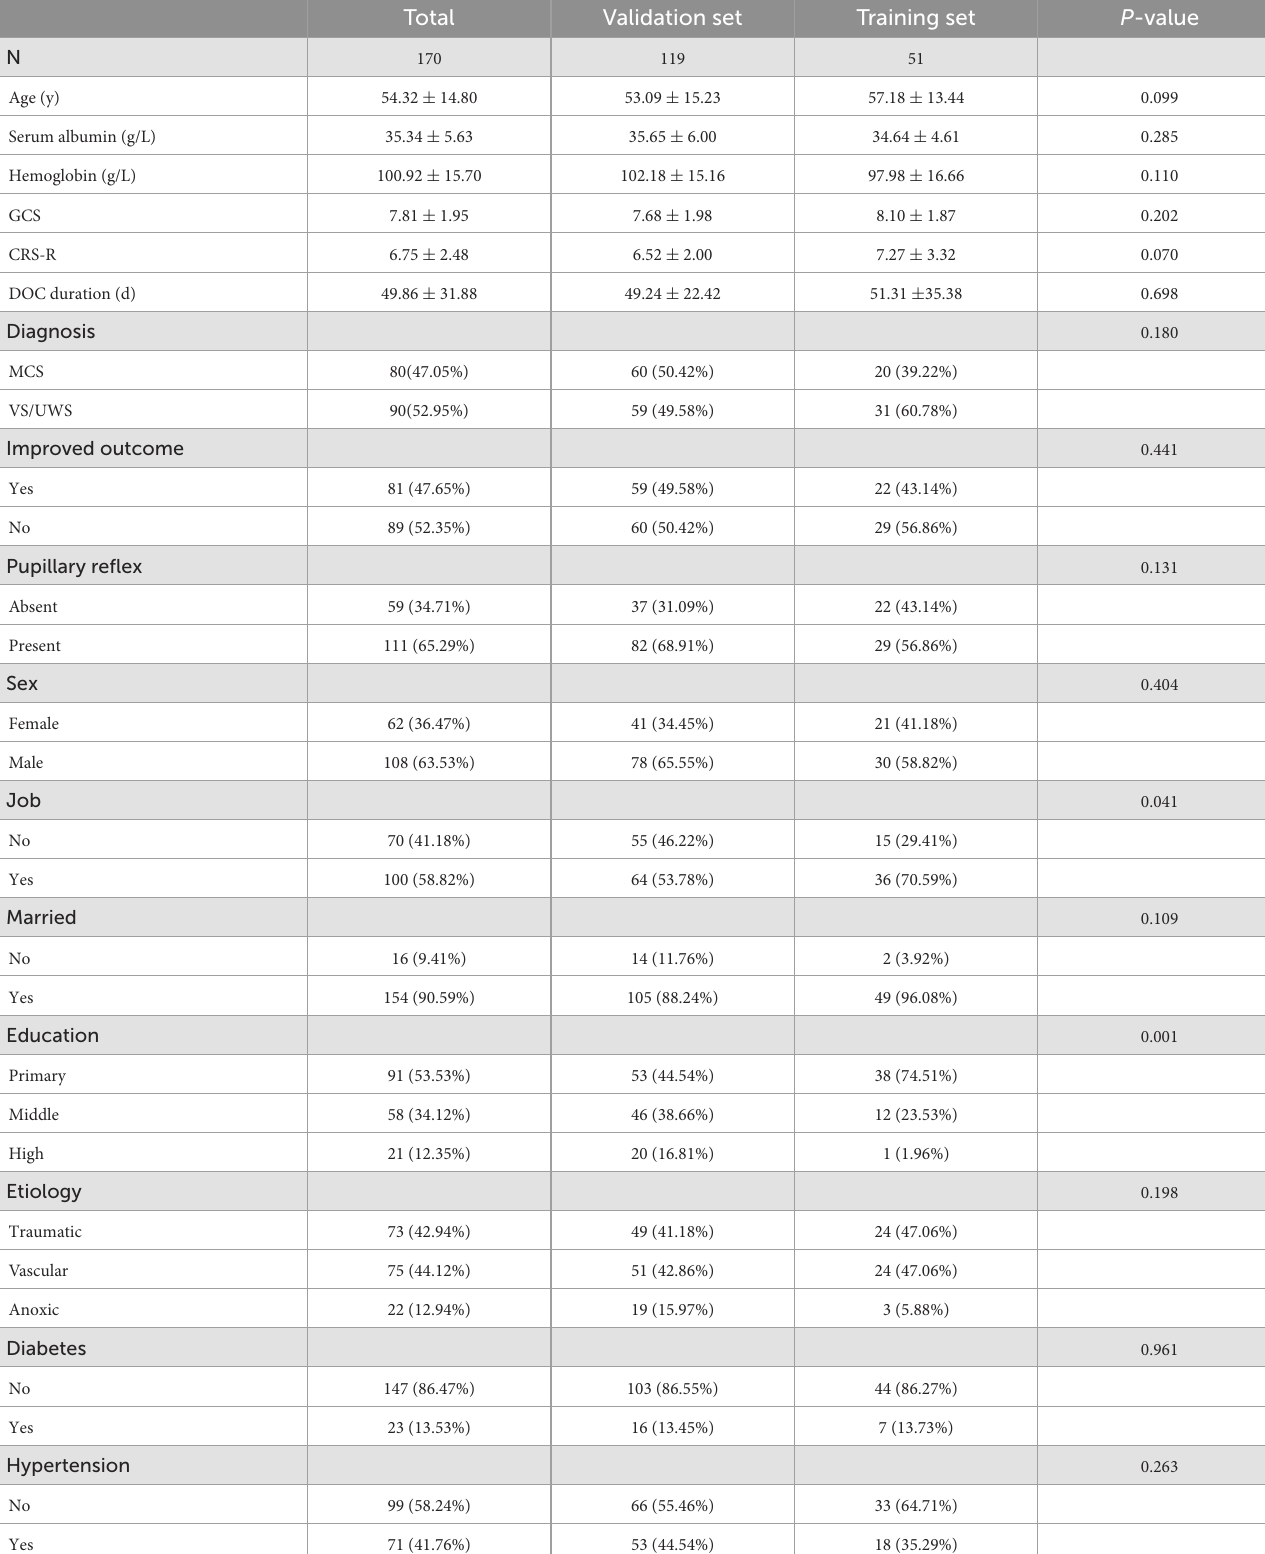
TABLE 1 Demographic and clinical characteristics of patients with